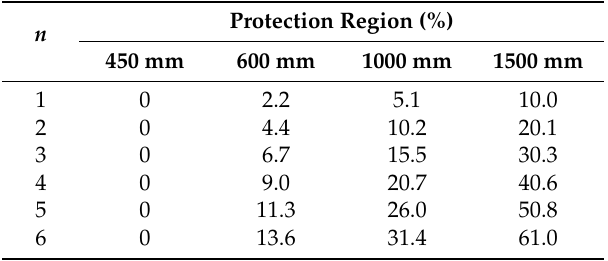
Table 6. Influence of conductor on protection region of arcing